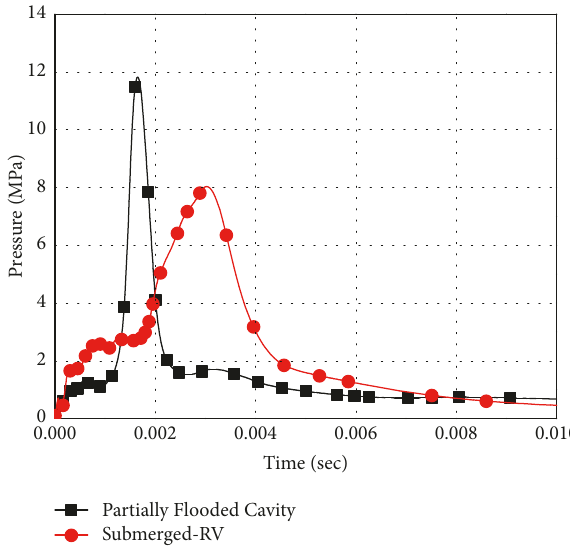
Figure 14: Maximum pressure calculated at the bottom of the water tank in both cases.